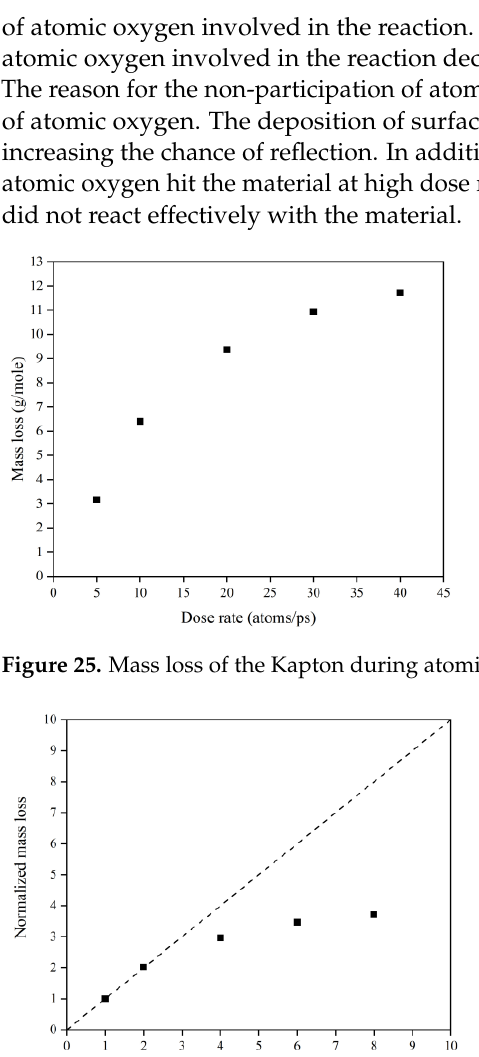
Figure 26. Normalized mass loss of the Kapton during atomic oxygen impact at different dose rates.